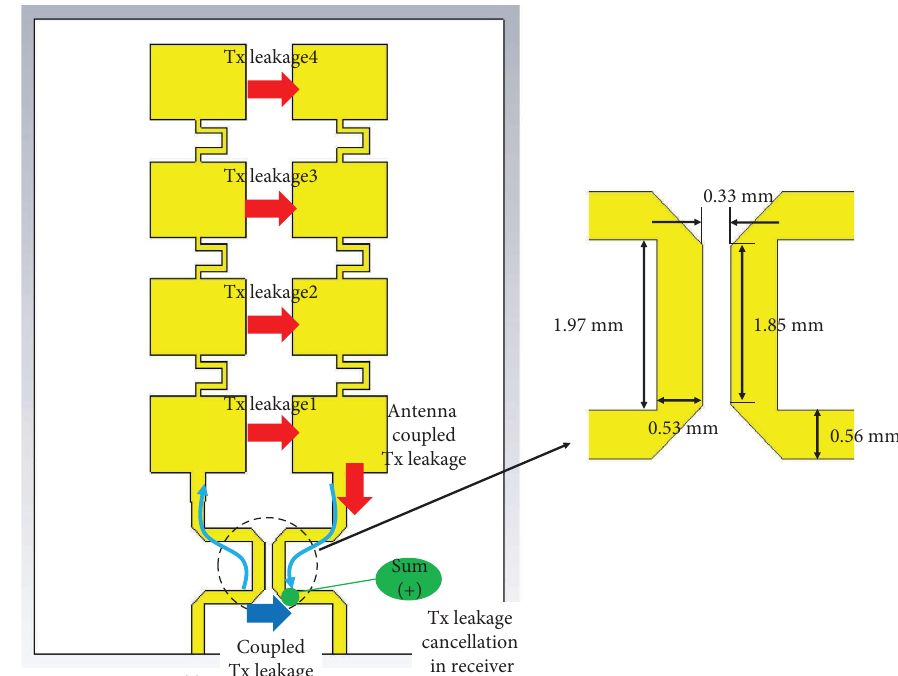
Figure 10: Tx and Rx arrays using the proposed decoupling network.